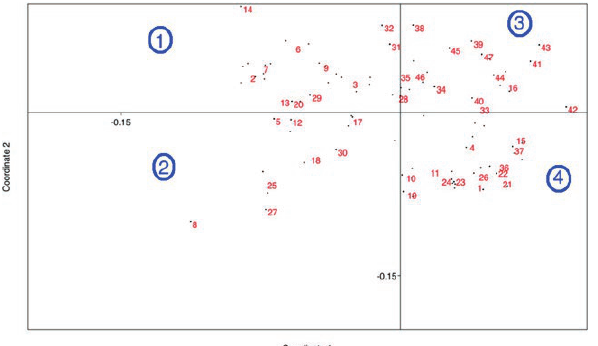
Figure 4. DLA plot of Punica genotypes based on SCoT data.